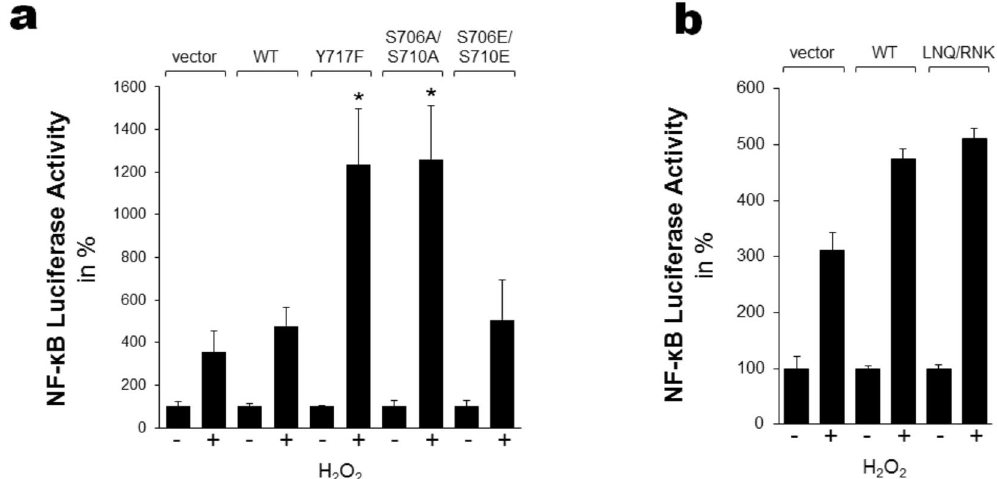
Figure 8. Signaling to NF- κ B by different PKD2 mutants in oxidative stress conditions. ( a ) HeLa cells were co-transfected with control vector, indicated PKD2 expression constructs and NF- κ B-luciferase and β -Galactosidase reporters. 4 hours after transfection, cells were stimulated with 500 µ M H